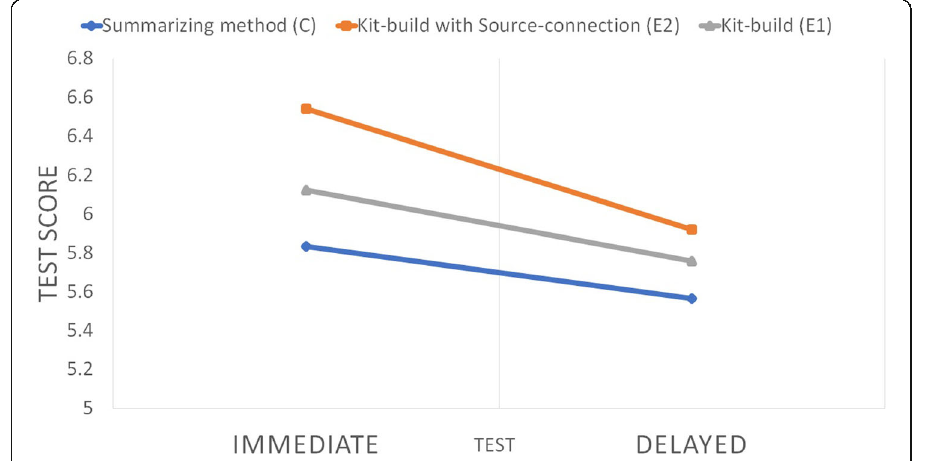
Fig. 7 Graphical test result comparison between groups for Material